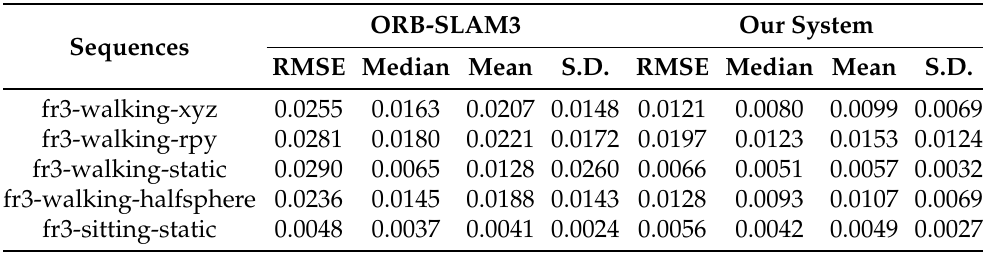
Table 2. Results of Relative Pose Error (RPE includes RMSE [m], Median [m], Mean [m], S.D. [m]).